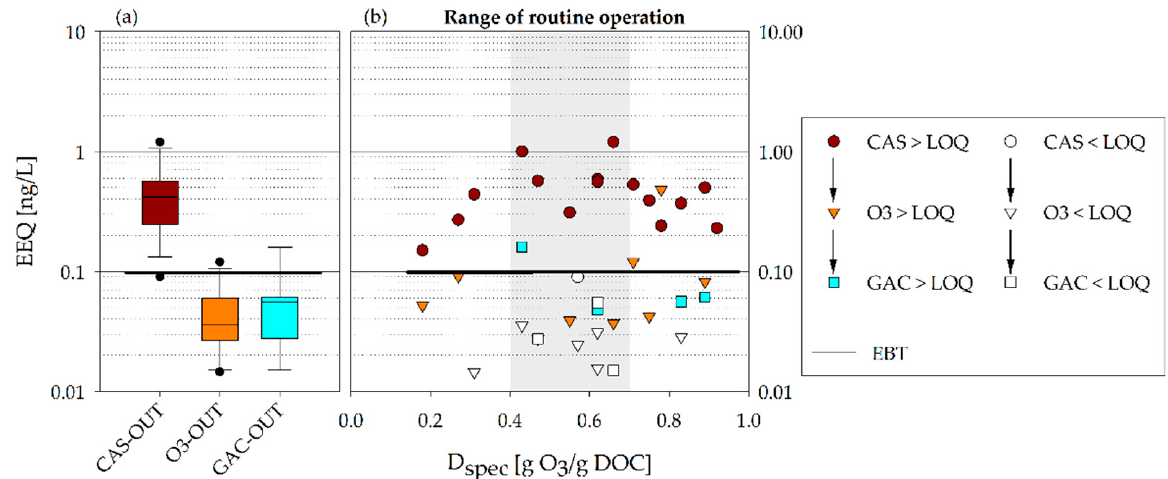
Figure 5. ( a ) Boxplot showing the range of 17 β estradiol equivalents over all campaigns along the multibarrier system; ( b ) EEQ along the multibarrier system for each sampling campaign.